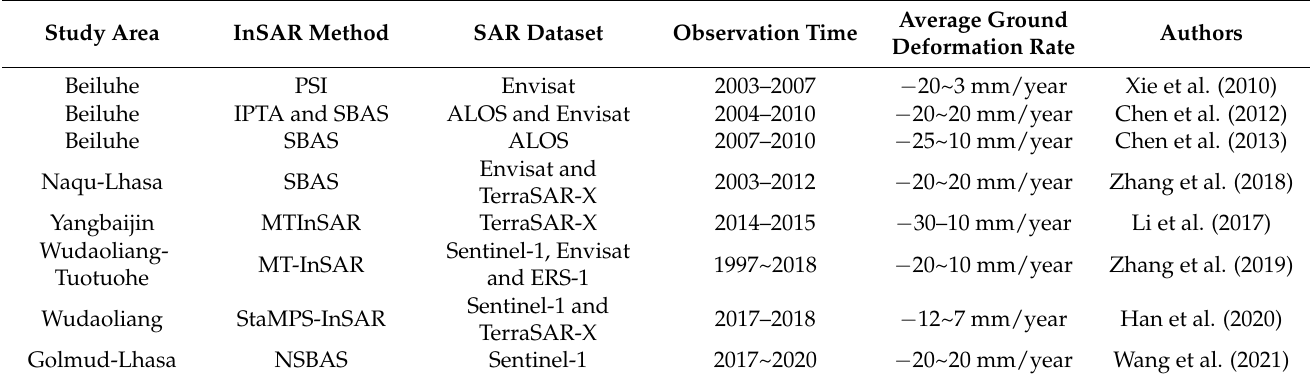
Table 6. Previous studies on permafrost deformation in the